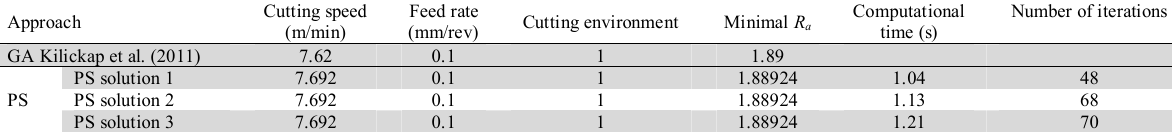
Comparison of optimization solutions for drilling process Approach